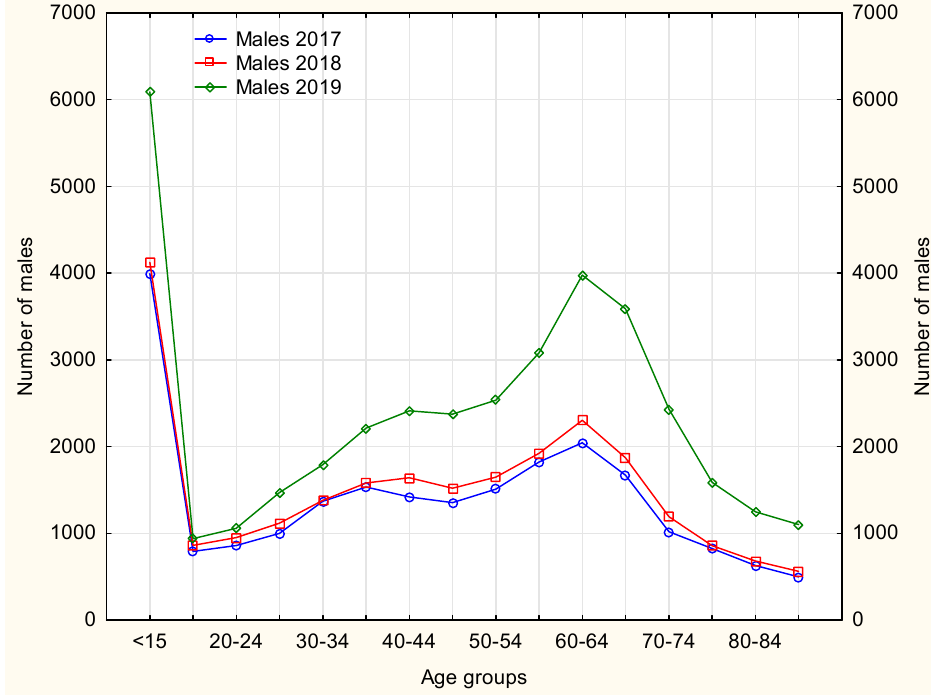
Figure 7. The number of male patients visiting the GP in each of the analyzed years separately according to age groups.